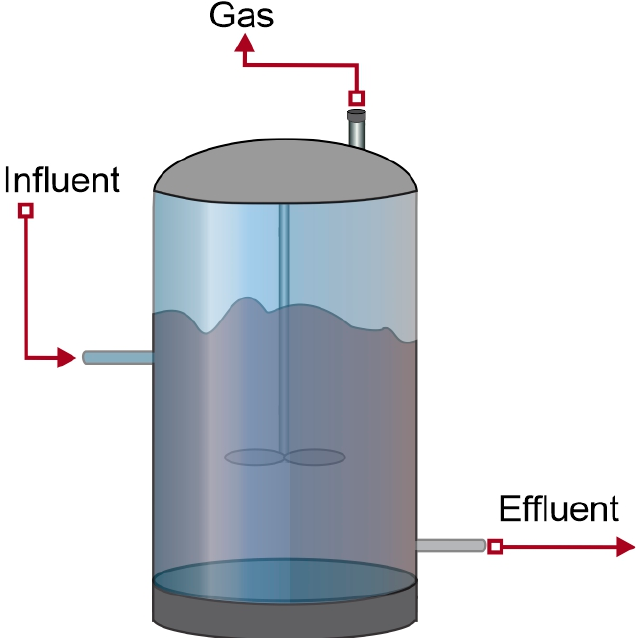
Figure 4. Total-Mixed Digester.